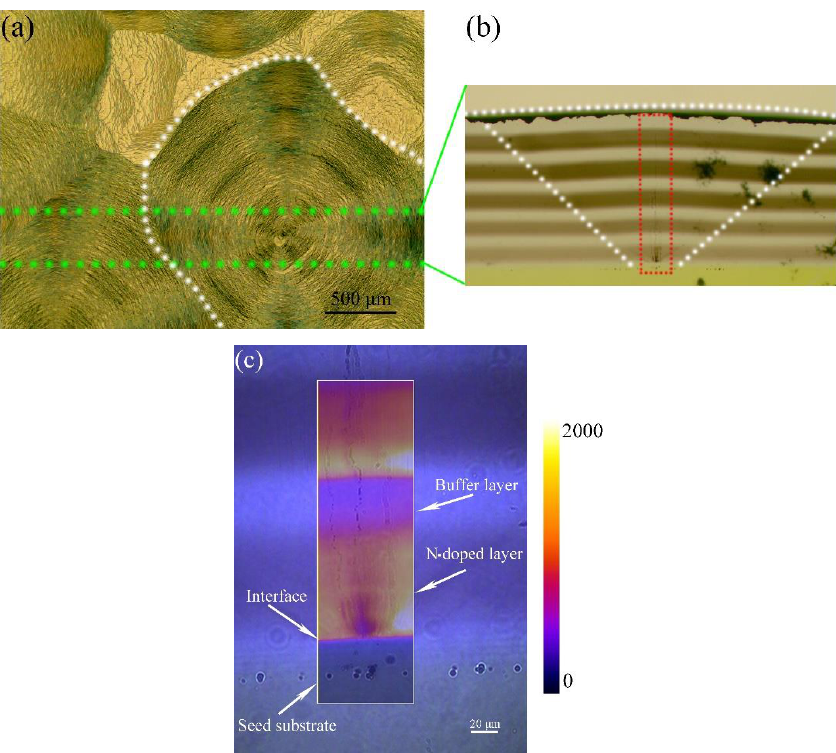
Figure 5. ( a , b ) Optical images showing the surface morphology and the cross section of the pyramidal feature, respectively. ( c ) Raman image of the defect formed at the interface was recorded by measuring the signal intensity at 1420 cm − 1 (corresponding to the emission from the NV 0 defect).